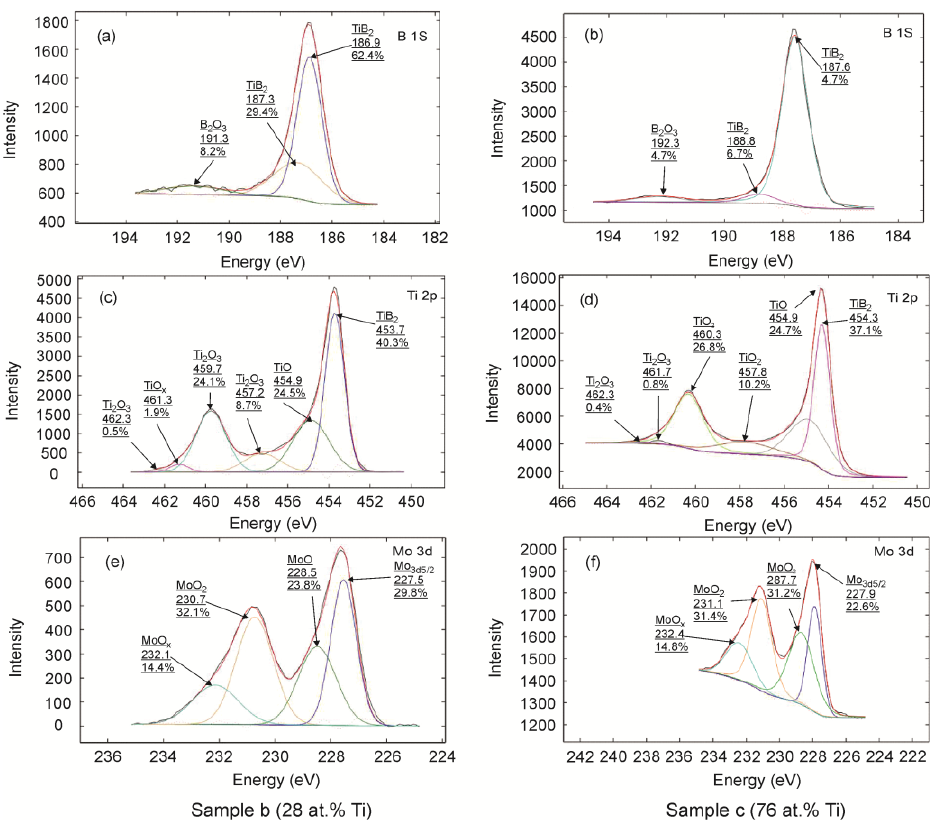
Figure 7. Sample b ( a , c , e ) and sample c ( b , d , f ) photoelectron spectra of ( a , b ) B 1s, ( c , d ) Ti 2p and ( e , f ) Mo 3d on rake face after total 1800 mm of milling.